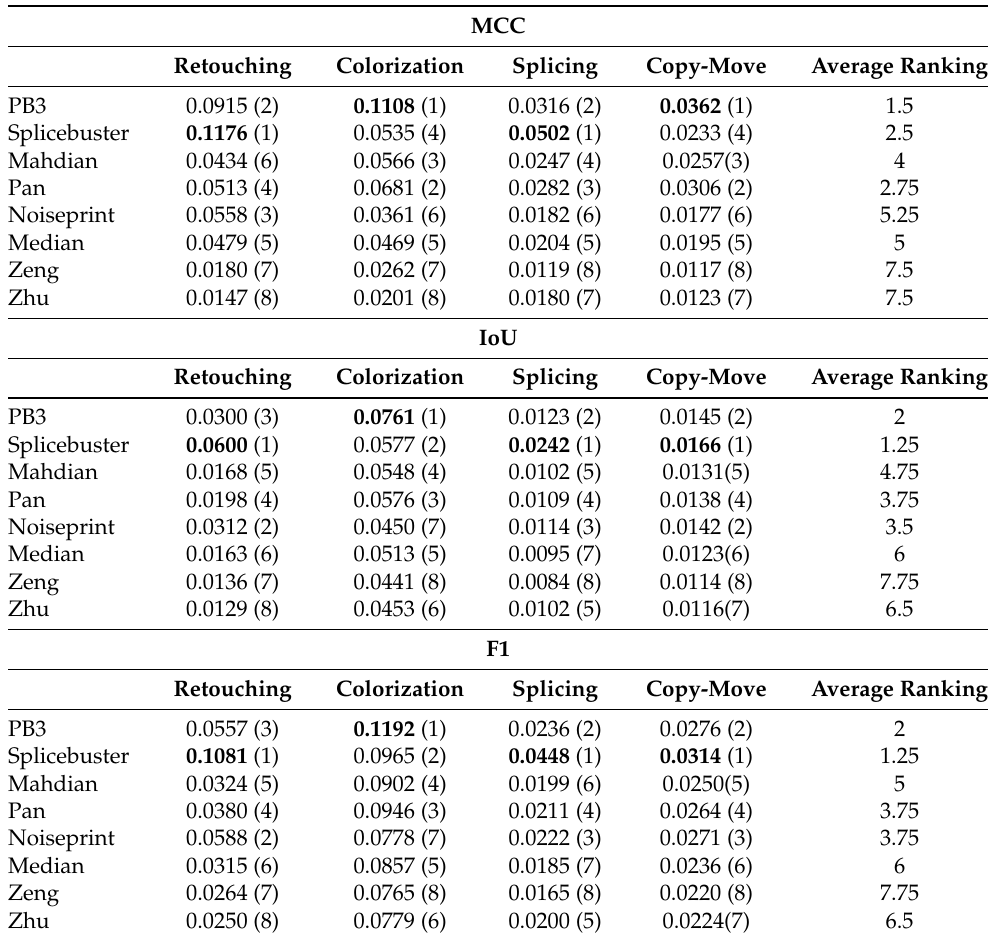
Table 4. Results of the evaluated methods measured by the average weighted IoU, F1 and MCC scores for each dataset that maximized the